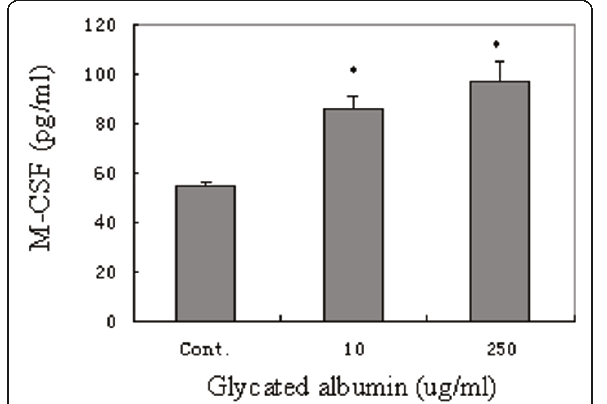
Figure 5 M-CSF release from purified microglial cells stimulated with 0, 10, or 250 μ g/mL glycated albumin (GA) for 24 h . GA significantly induces the release of M-CSF, compared with the control. The results are shown as means ± SD of three